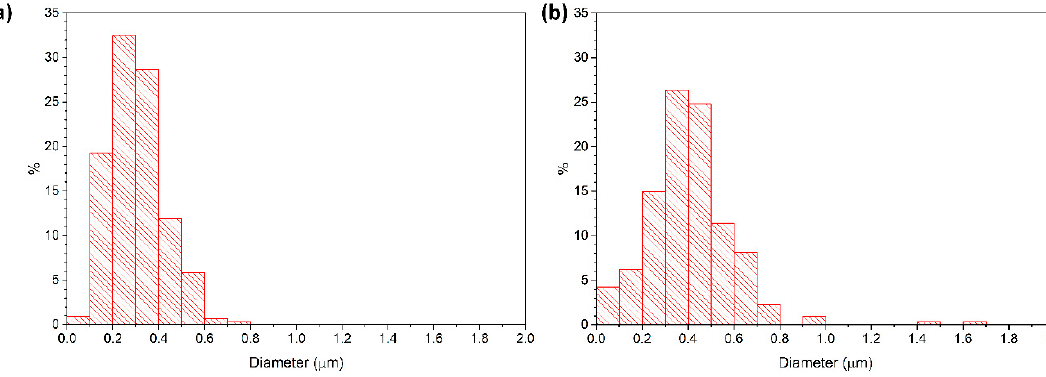
Figure 10. Grain size distributions of ( a ) a two-step sintered sample (T1 = 1400 °C, T2 = 1350 °C, t2 = 20 h) and ( b ) a conventionally sintered sample. Both samples prepared from as-received powder.